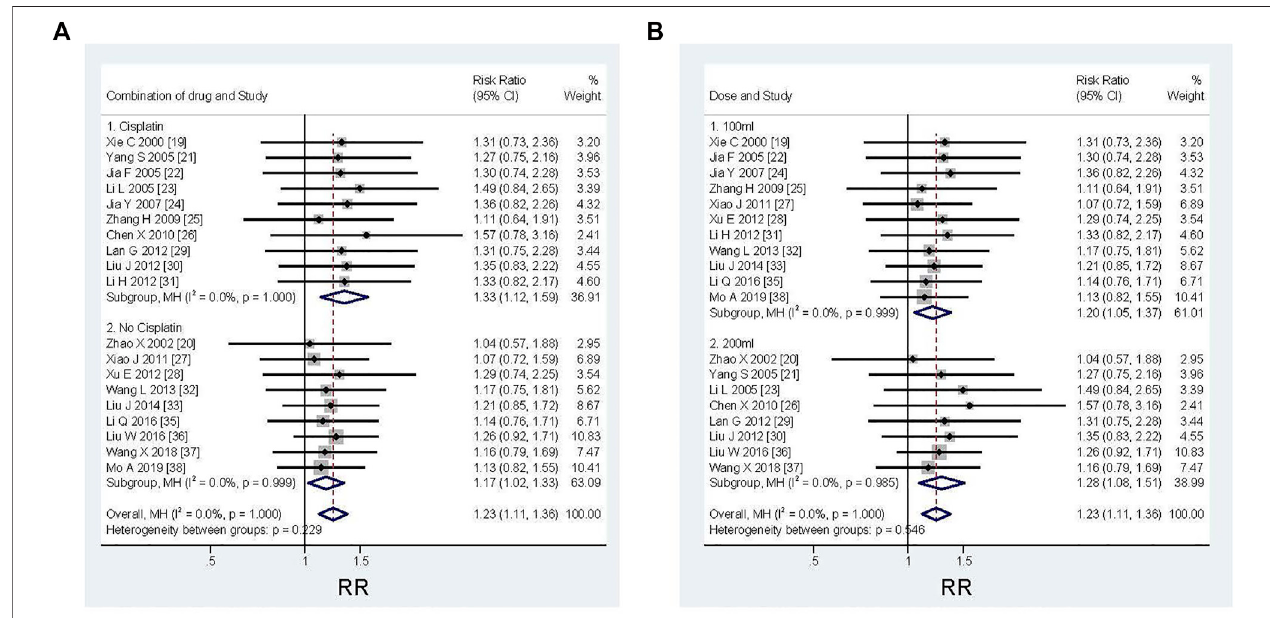
FIGURE 3 | Ef fi cacy comparison of KLTI combined with another agentversus another agent alone by thoracic perfusion for controlling MPE. Subgroup analysis of different types of chemotherapeutic drugs: when combined with cisplatin, the improvement of ORR is more advantageous; Subgroup analysis of different KLTI dosage: the ORR was more advantageous when using KLTI 200 ml each time. RR, Risk ratio; ORR, Objective response rate; KLTI, Kanglaite injection.